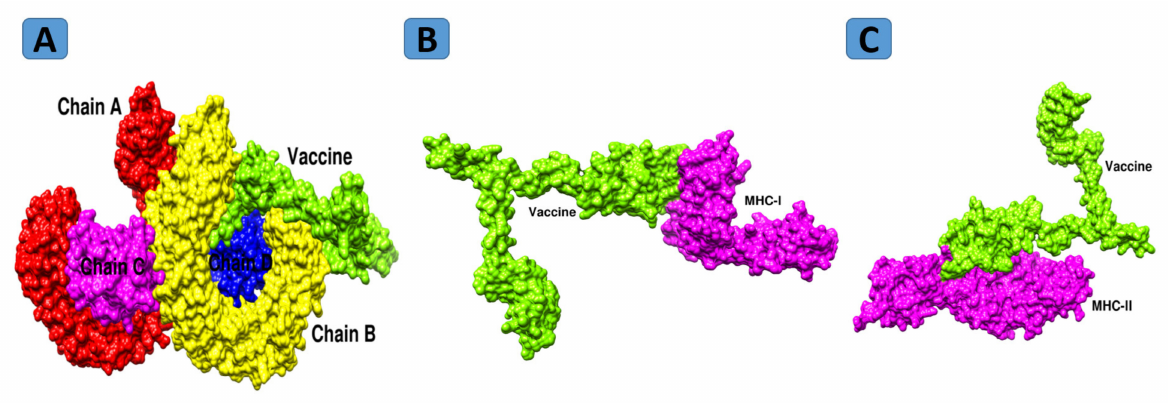
Figure 8. Docked conformation of vaccine with TLR4 ( A ), MHC-I ( B ), and MHC-II ( C